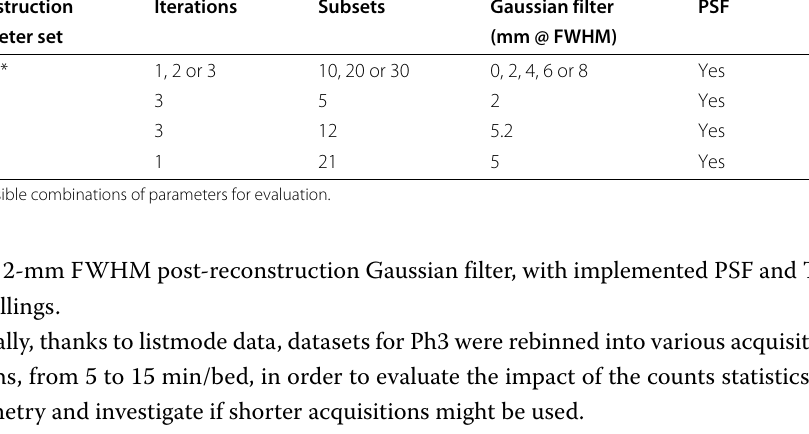
Table 1 Parameter sets used for listmode data reconstructions